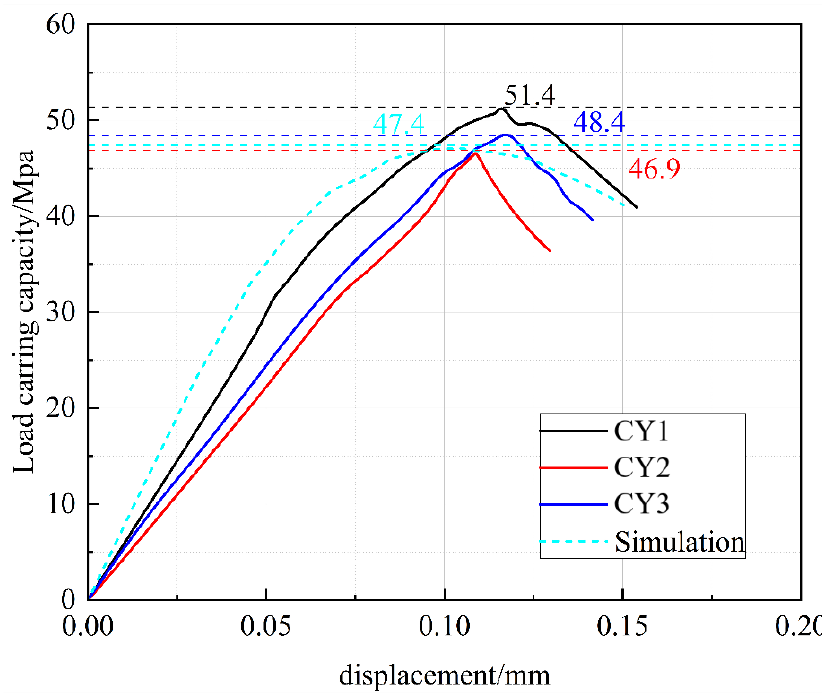
Figure 20. Load–displacement curves associated with the Y-axis compression test and corresponding numerical simulation.